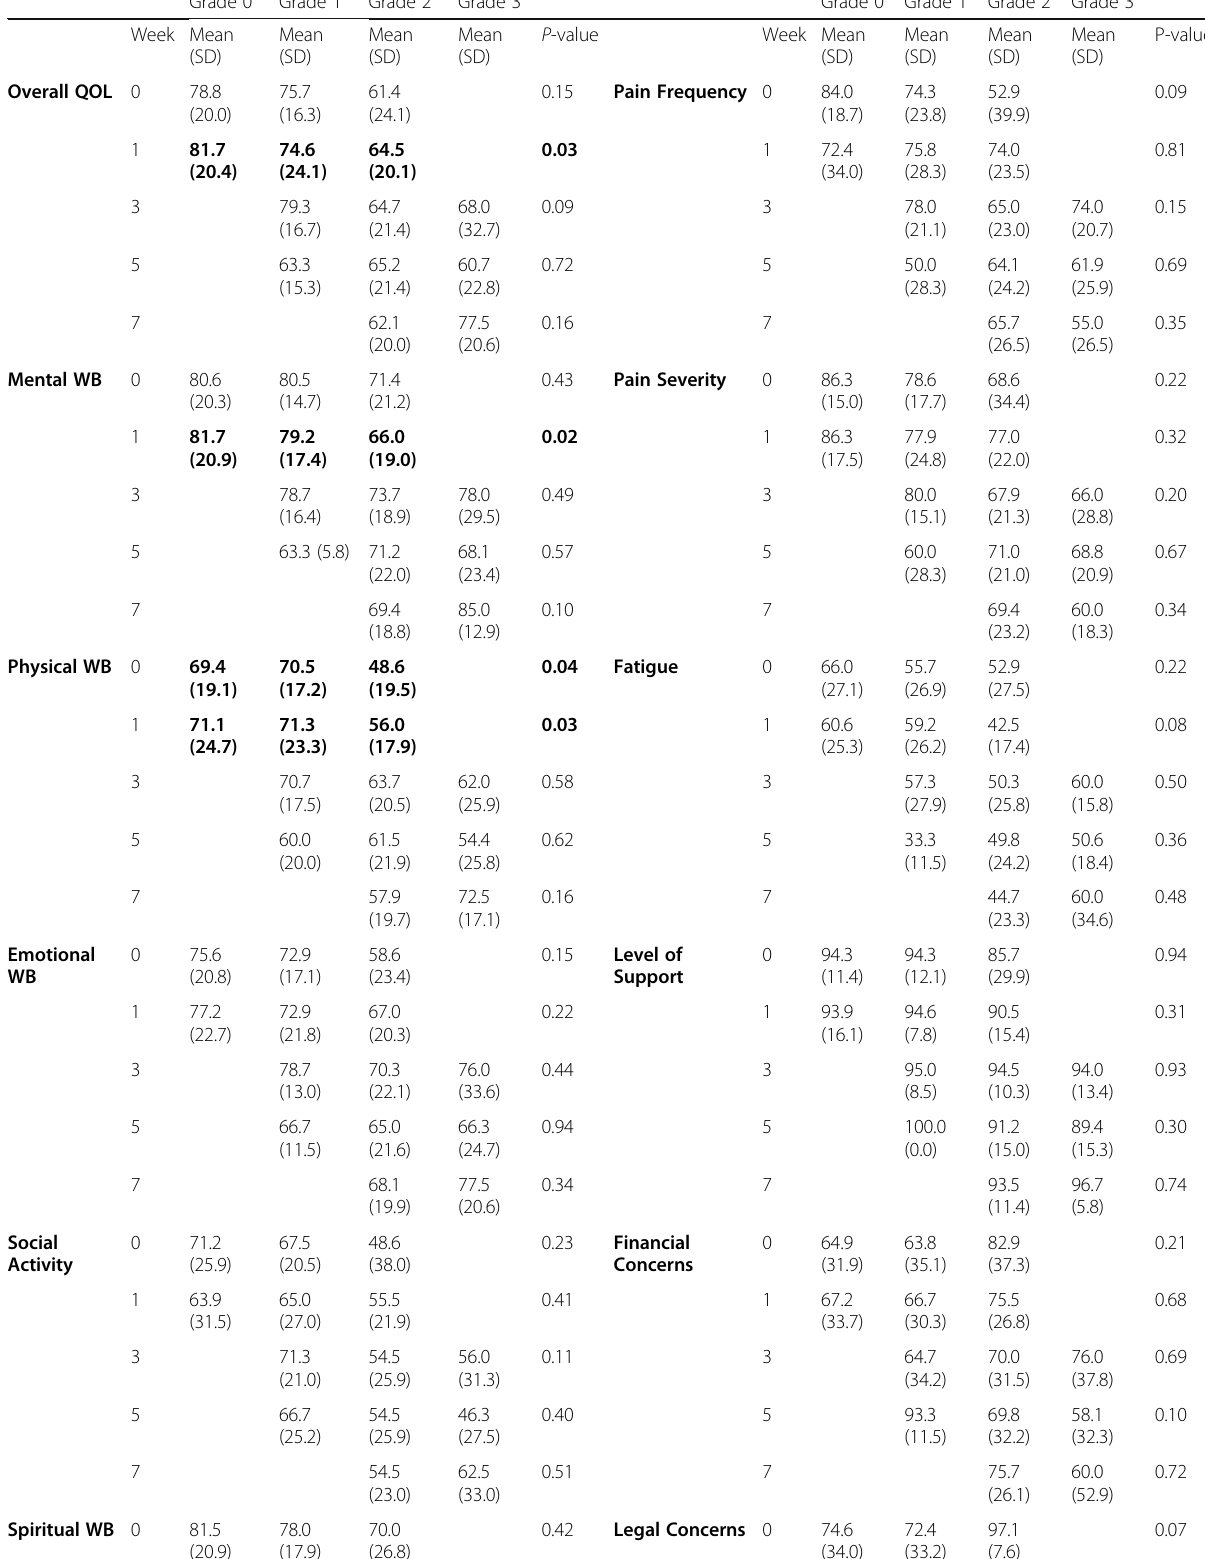
Table 2 QOL Scores by Maximum Grade Adverse Event Per